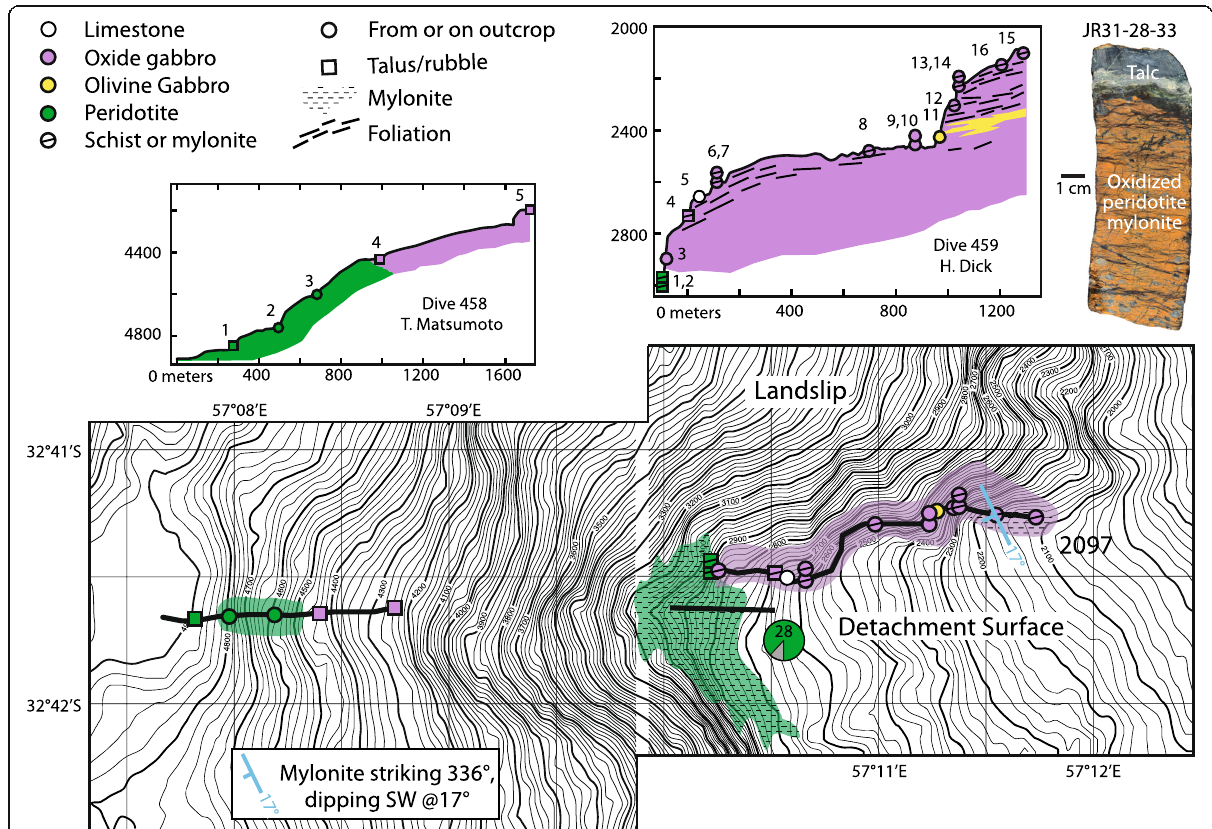
Fig. 34 Shinkai Dives 458 and 459 (Fig. 3) in profile and plan view. Dive scientists were T. Matsumoto and H. Dick. Dive 459 ended 8 km west of IODP Hole U1473A producing the unusual dive profile (distance along track versus depth) as it started on the lip of a landslip, dropped down on the headwall scar, and then rose back up onto the detachment footwall. Sample 459-5, from 2647 m depth, is semi-consolidated oolitic limestone. Dredge 28 recovered 95 kg of peridotite mylonites and ~ 2 kg of gabbro, mostly veins from the detachment fault damage zone. Sample 33 (upper right) is characteristic of many of these with a talc rim, likely representing the late slip zone after hydration along the fault plane. Note the crisscrossing black veins representing static serpentinization of the mylonite below the sheared talc. Dive 459 first